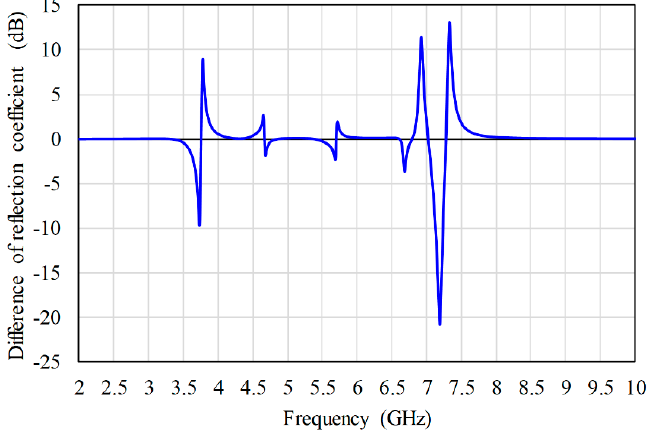
Figure 10. Amplitude difference between vertically and horizontally polarized S 11 for code “0101010101”.